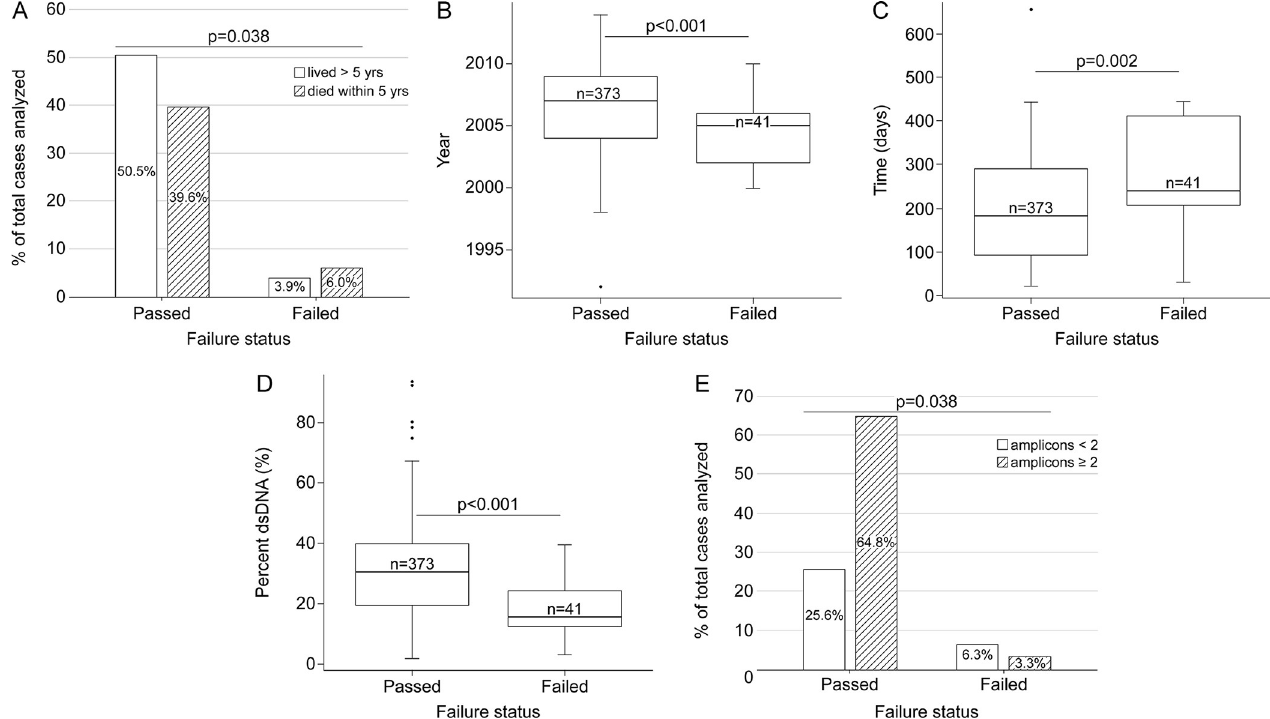
Fig 5. Effect of case, tumor, DNA characteristics, and logistics, on the success of methylation screening.